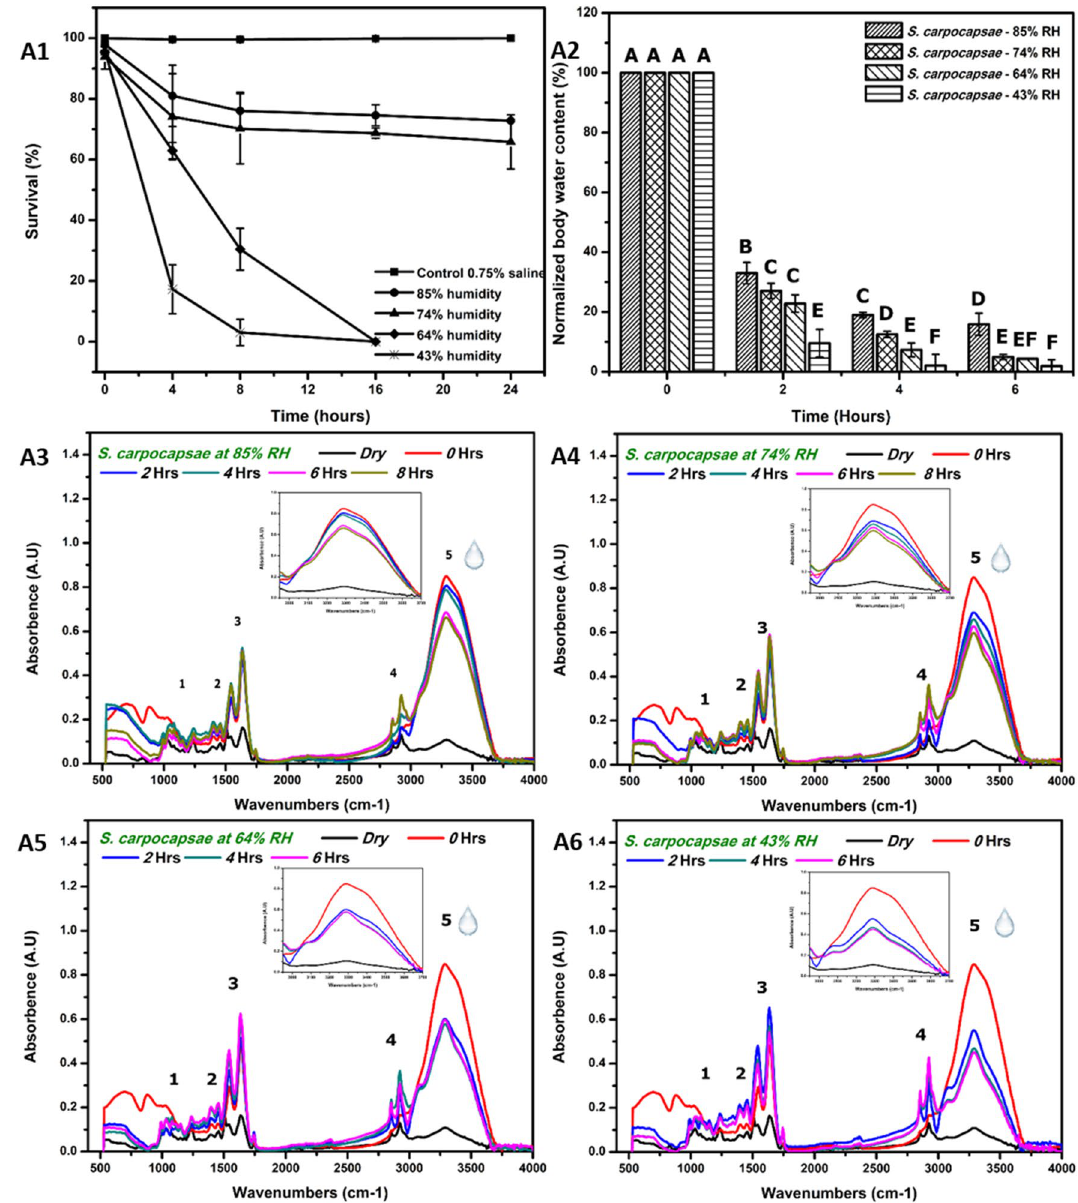
Figure 2. Rapid desiccation of S. carpocapsae at 85, 74, 64 and 43% RH. ( A1 ) In-vitro survival (%) of S. carpocapsae at different humidity for 0, 4, 8, 16 and 24 h. ( A2 ) Gravimetric rate of water loss of S. carpocapsae rapidly desiccated for 0, 2, 4, 6 h at different RH. ( A3 – A6 ) FTIR fingerprint spectra of rapidly desiccated S. carpocapsae at 85, 74, 64 and 43%RH for 0, 2, 4 and 6 h. Inlet in each figure represents the peak of OH (water)/ NH bonds. The numbers inside the spectra represents the groups strongly affected due to different humidities (see Table S1 for assignment of functional groups). Survival (%) (n = 360) and gravimetric water loss (%) (n = 156) were arcsine square-root transformed and subjected to comparison of standard least squares by REML. When ANOVA F was significant (p < 0.05), means were compared. Mean was compared using Tukey test. Different alphabets represent significant